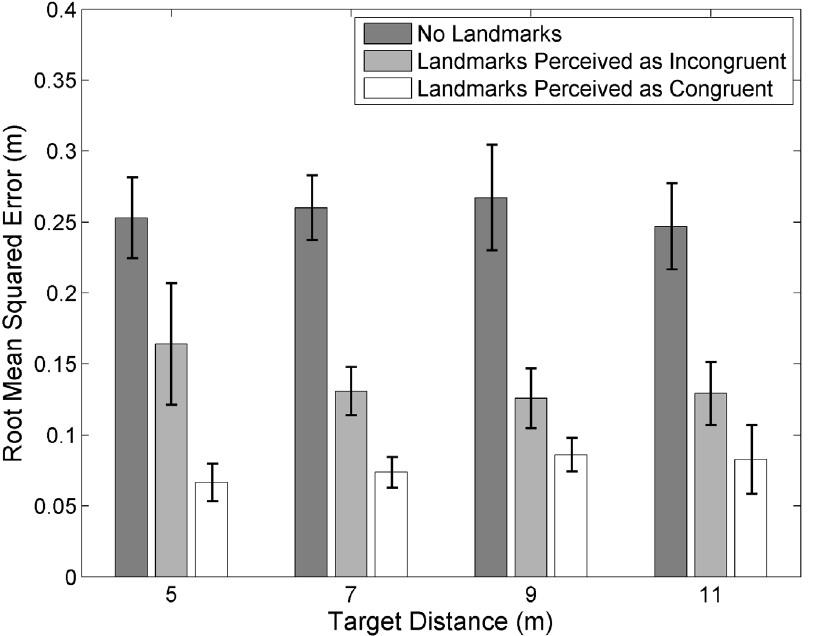
Figure 5. Precision of estimates in the combined cue task. The variability (root mean squared error) of localization estimates collapsed across viewing conditions when: 1) no landmarks, 2) remembered landmarks were judged to be incongruent with path integration information, and 3) remembered landmarks were judged to be congruent with path integration.